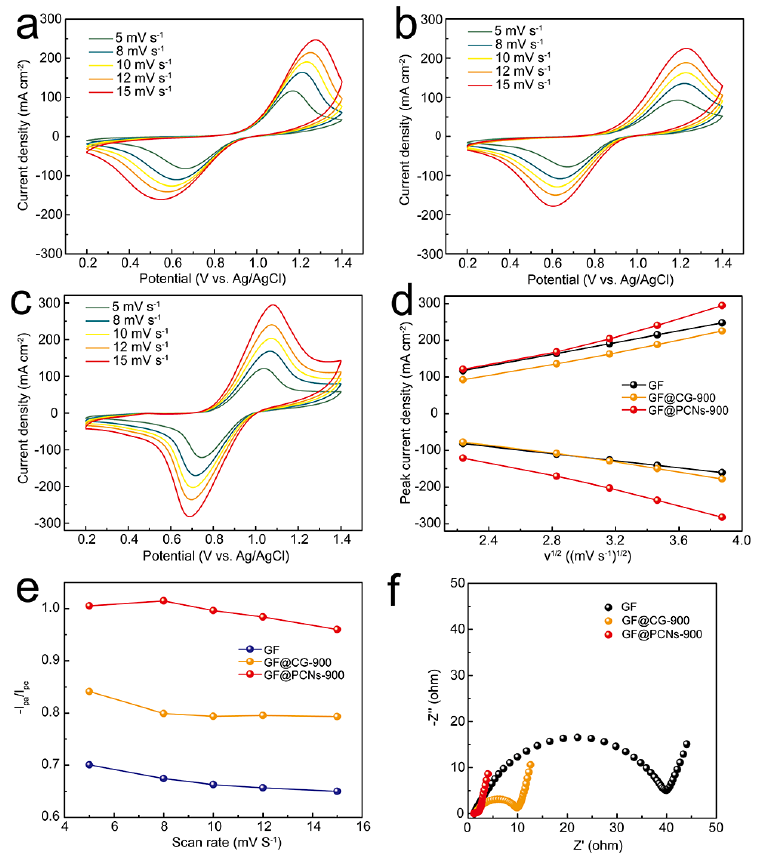
Figure 8. Multi-sweep tests of ( a ) GF, ( b ) GF@CG-900, ( c ) GF@PCNs-900 at various rate of 5, 8, 10, 12 and 15 mV/s, ( d ) the relationship curve between the square root of scan rate and peak current density, ( e ) the relationship between the peak current ratio and scan rate, ( f ) the Nyquist plots of the GF, GF@CG-900 and GF@PCNs-900.